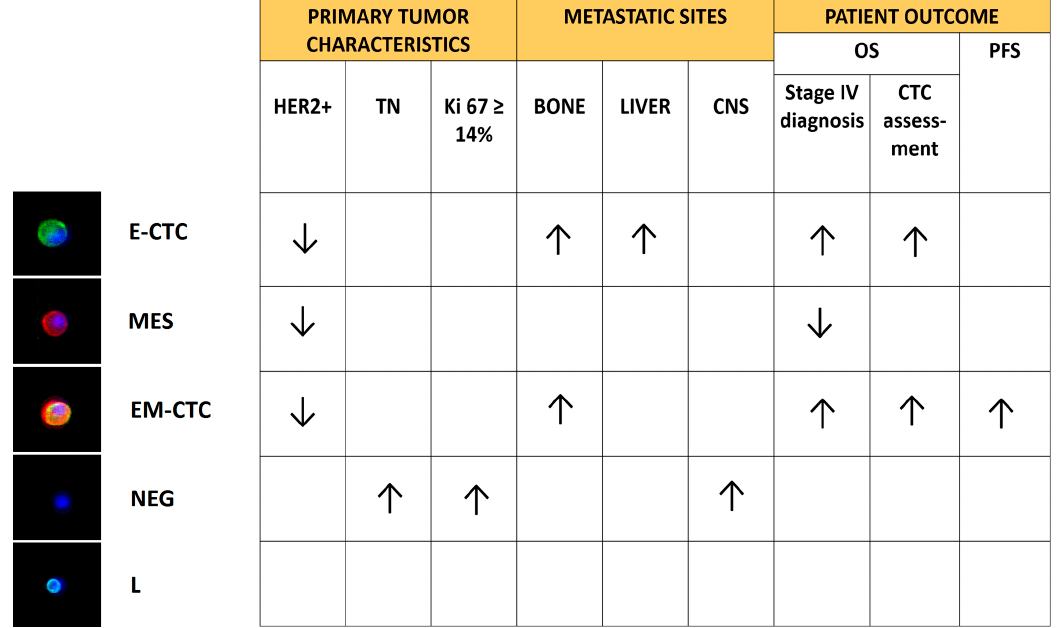
Figure 1. CTC in EMT can predict prognosis. CD45-depleted blood samples of MBC patients were assessed for the presence of nucleated cells (recognized by the blue staining of DAPI) expressing epithelial (green fluorescence), mesenchymal (red fluorescence) and leukocyte (cyan fluorescence) markers. As depicted on the left panels, besides CD45-positive leukocytes (L), 4 subsets of CD45-negative cells were detected: cells expressing only epithelial markers (E-CTC), cells co-expressing epithelial and mesenchymal markers (EM-CTC), cells expressing only mesenchymal markers (MES) and cells negative for all the assessed markers (NEG). Increased ( ↑ ) or decreased ( ↓ ) number or proportion of these subsets was significantly associated with specific clinical-pathological features and patient outcome. OS, overall survival; PFS, progression free survival; TN, triple negative; CNS, central nervous system [46].